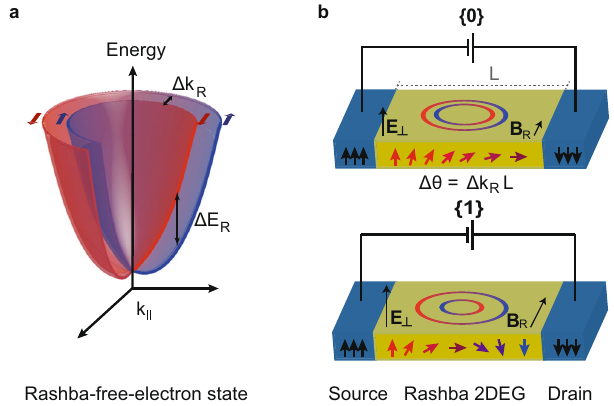
Fig. 1 Rashba spin-orbit coupling in two-dimensional electron gas. a Rashba spin-orbit-coupling (RSOC) splits a free electron state into two subbands carrying opposite spin texture (red and blue). The splitting of the free electron state in both energy ( Δ E R ) and momentum ( Δ k R ) is proportional to the RSOC strength α R , which is tunable with an electric fi eld E ⊥ . This Rashba splitting locks the electron's spin to its momentum. b Fundamental design of a spin fi eld-effect transistor (spinFET) in which spin-polarized electrons are injected from a source into a Rashba 2DEG and collected with a ferromagnetic drain. Due to the momentum-dependent splitting of Rashba 2DEGs, charges traversing from source to drain feel an effective magnetic fi eld, B R , proportional to α R , perpendicular to their direction of motion, causing their spin to precess. The spin polarization of carriers changes by the angle ΔΘ = Δ k R L , where L is the length of the 2DEG. Modulating Δ k R — conventionally via an electric fi eld — switches the spinFET between a state of high {0} and low {1}